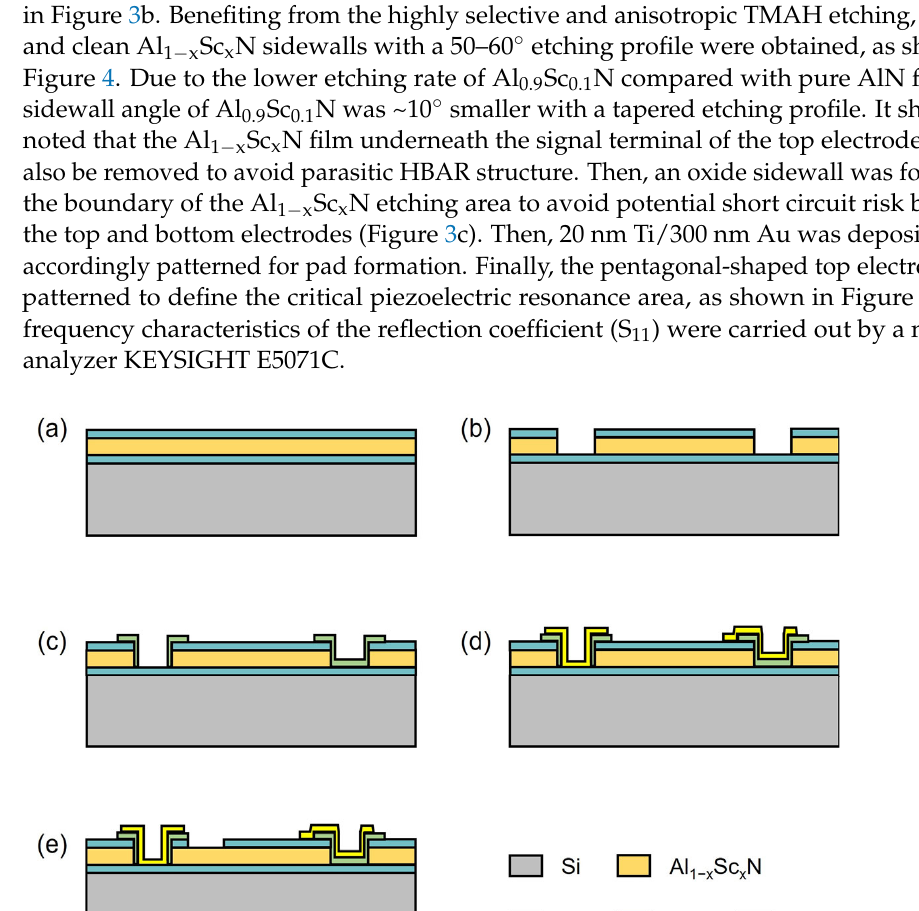
Figure 4. Cross ‐ section SEM images of ( a ) AlN and ( b ) Al 0.9 Sc 0.1 N piezoelectric stacks. 3. Results and Discussion 3.1. d 33 Measurement by Synchrotron XRD Method The in situ synchrotron XRD curves of AlN, Al 0.9 Sc 0.1 N and Al 0.8 Sc 0.2 N films under different applied voltages are shown in Figure 5. In general, the diffraction peaks of the Al 1 − x Sc x N (0002) plane, reflecting the c ‐ plane lattice spacing with different Sc concentra ‐ tions and applied electric field, are located between 28.5° to 28.9°. As shown in Figure 5a, without external voltage, a distinct peak corresponding to AlN (0002) is located at 28.85°. A clear peak shift of 0.013° to lower angles was observed when a negative voltage of − 100 V was applied; while an opposite 0.010° shift to higher angles was observed upon the application of positive 85 V. Synchrotron XRD curves of Al 1 − x Sc x N films with Sc concen ‐ trations of 10% and 20% exhibit similar phenomena, with peak shifts of 0.010° and 0.015° for Al 0.9 Sc 0.1 N and Al 0.8 Sc 0.2 N films under applied voltages of 60 V and 40 V separately, as shown in Figure 5b,c. It should be emphasized that thanks to the high resolution of the synchrotron radiation ‐ powered X ‐ ray source, diffraction peak shifts as small as 0.001° can be clearly distinguished. This behavior corresponds to the inverse piezoelectric effect of piezoelectric film, and can in turn be used to calculate the piezoelectric coefficient. By ap ‐ plying a longitudinal electric field E on the piezoelectric films and calculating the change rate of (0002) interplanar spacing (d E– d 0 ) / d 0 , the longitudinal strain S and the piezoelectric coefficient d 33 of piezoelectric films can be obtained according to Equation (1) [33]: